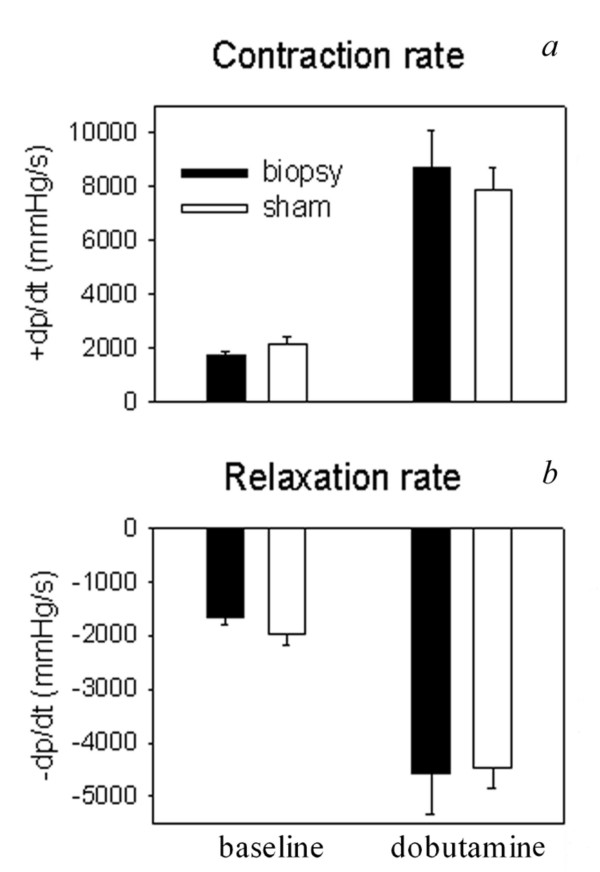
Two weeks after surgery, contraction rate (+dP/dt) (a) and relaxation rate (-dP/dt) (b) of 6 rat hearts from which biopsies were taken were compared to data obtained from 6 sham-operated rats. Data were obtained by direct LV pressure measurements using a micro-tip pressure transducer (Millar Instruments, Tx, USA) inserted into the left ventricle. Data were obtained at baseline as well as during dobutamine-stimulated conditions.